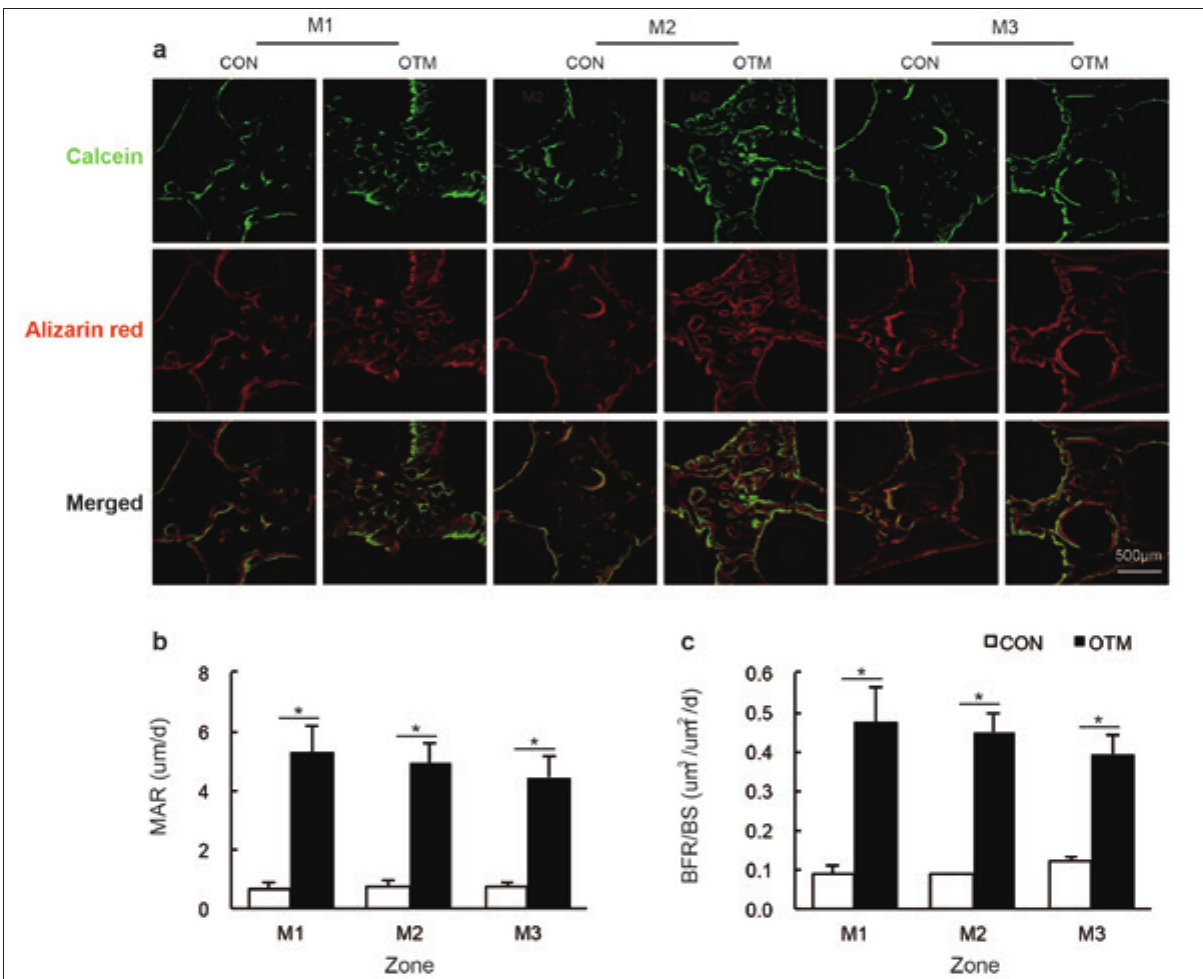
Figure 5. Sequential fluorochrome labeling analysis indicated that the local orthodontic force increased the entire bone deposition rates. The MAR and BFR/BS of the alveolar bone in M1, M2 and M3 zones were all elevated during OTM. (* p < 0.05, N =